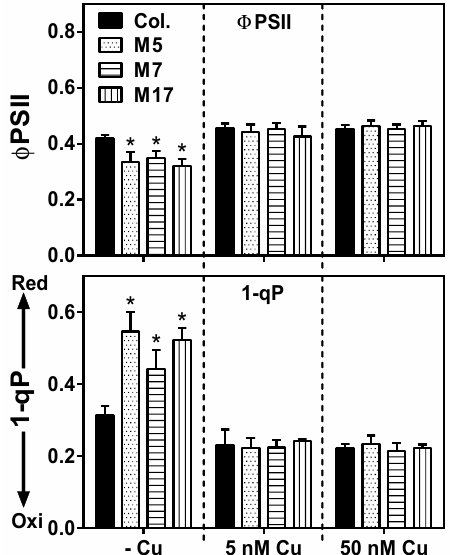
Figure 4. Photosynthetic electron transport parameters as measured by chlorophyll fluorescence. FluorCam measurement done on dark-adopted rosette leaves from WT (Col.) and transgenic lines (M5, M7, M17) growing in hydroponic culture at 0, 5, or 50 nM CuSO 4 , where values are given as averages ± SD ( n = 6). Top panel: Φ PSII (estimate of electron transport). Bottom panel: 1-qP (indicative of the redox state of the plastoquinone pool). * indicate significant differences between lines within a growth condition ( p < 0.05, Student’s t -test).